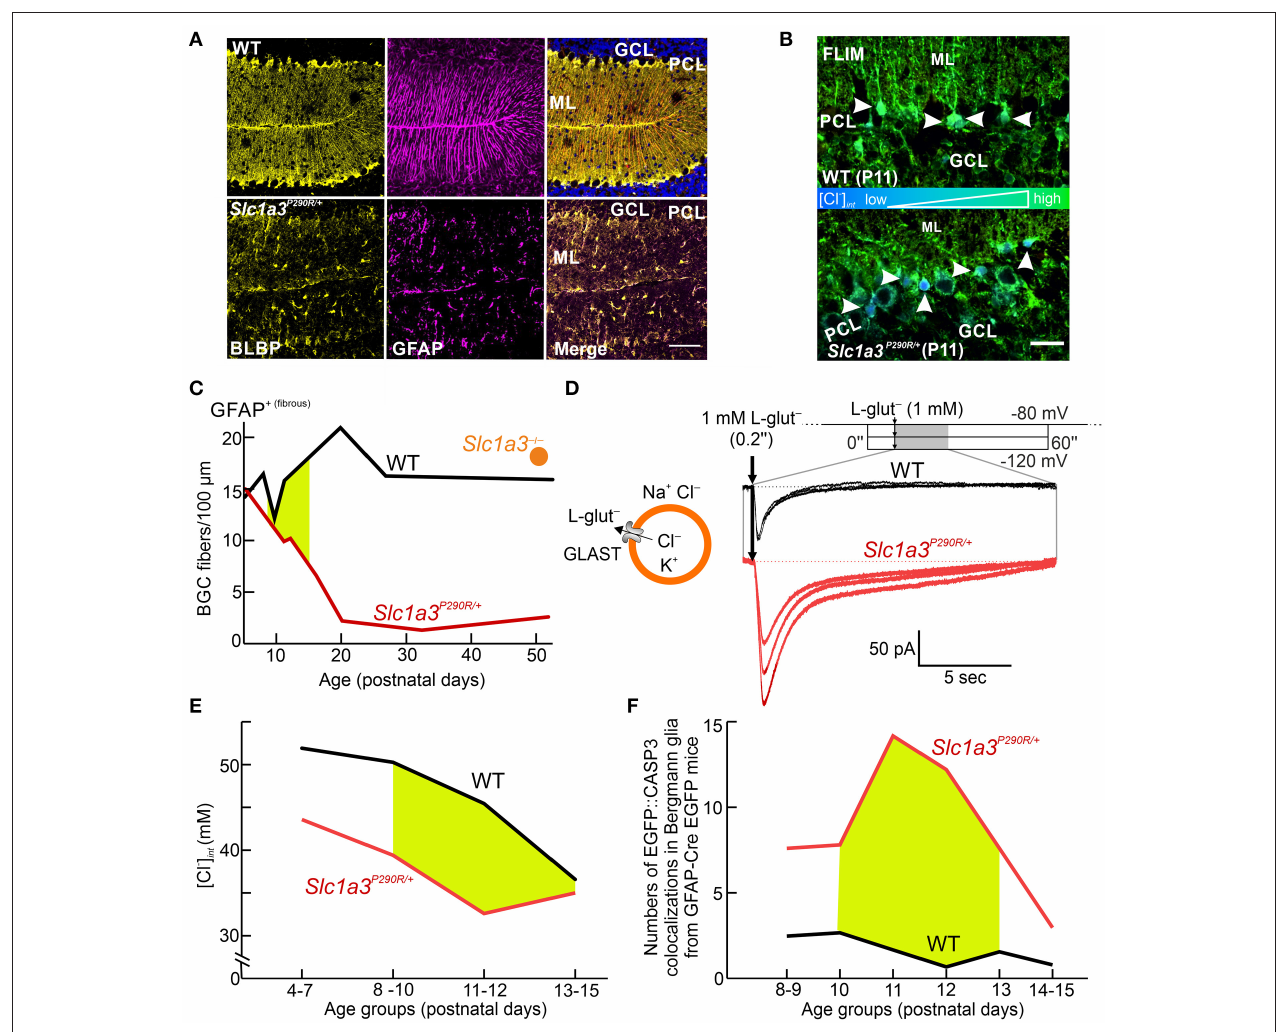
FIGURE 5 | Cellular Cl − depletion causes apoptosis in Slc1a3 P 290 R / + Bergmann glial cells. (A) Confocal images show the disappearance of Bergmann glial cells (BGCs) in young mice (P20) heterozygous for the P290R mutation in EAAT1/GLAST by immunostaining BGCs for brain lipid-binding protein (BLBP, yellow) and glial fibrillary acidic protein (GFAP, magenta). (B) FLIM imaging of cerebellar cortices from wild-type (WT) and Slc1a3 P 290 R / + mice indicates that P290R decreases [Cl − ] int . Arrowheads depict MQAE-filled Bergmann glial cells. GCL, granule cell layer; ML, molecular layer; PCL, Purkinje cell layer. (C) Time course of BGC numbers in the cerebella of WT (black), Slc1a3 P 290 R / + (red), and Slc1a3 − / − (orange) mice shows that loss of BGCs occurs only in P290R mice—not in knockout animals. (D) Whole-cell patch-clamp recordings of acute brain slices from WT and Slc1a3 P 290 R / + animals show gain of function of Slc1a3 P 290 R / + anion channels in BGCs from mutant animals upon brief pulses of L -glutamate (L-glut). (E) [Cl − ] int is decreased in BGCs from Slc1a3 P 290 R / + mice at all stages of early postnatal development. The age period for BGC loss is shown in yellow. (F) Number of cerebellar CASP3 signals in GFAP-EGFP-expressing mice during the second week of life. Reprinted in part and modified from Kovermann et al. (2020), with